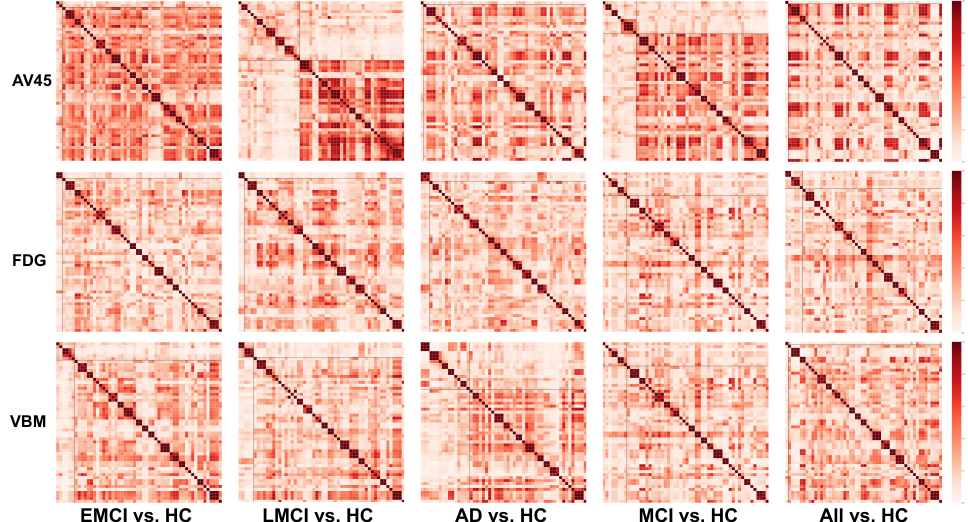
Figure 4. The SNP networks (54 by 54) constructed by the normalized cosine scoring function. Each entry is the cosine similarity of two corresponding SNP representations (measuring their association patterns with 116 ROIs in the brain). The black line indicates the partition of two